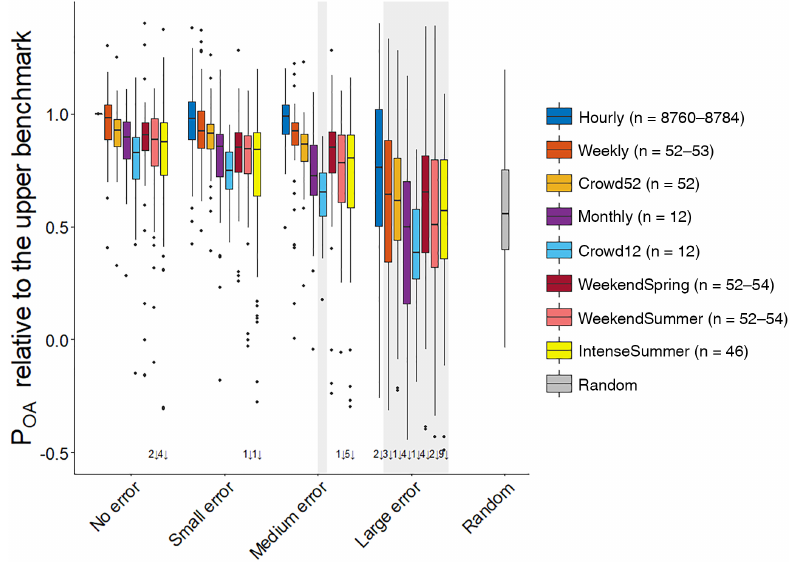
Figure 4. Box plots of the median model performance relative to the upper benchmark for all datasets. The grey rectangles around the boxes indicate non-significant differences in median model performance compared to the lower benchmark with random parameter sets. The box represents the 25th and 75th percentile, the thick horizontal line represents the median, the whiskers extend to 1.5 times the interquartile range below the 25th percentile and above the 75th percentile and the dots represent the outliers. The numbers at the bottom indicate the number of outliers beyond the figure margins; n is the number of streamflow observations used for model calibration. The result of the hourly benchmark FOEN dataset has some spread because the results of the 100 parameters sets were divided by their median performance. A relative P OA of 1 indicates that the model performance is as good as the performance of the model calibrated with the hourly FOEN data (upper